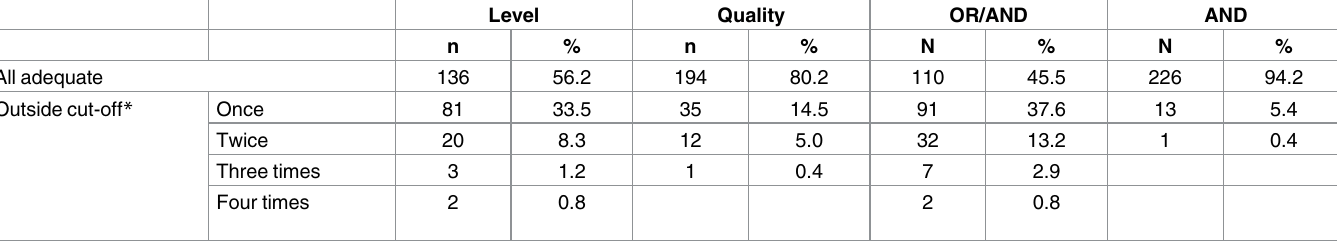
Table 3. Results of repeated assessmentsusing Structured Observation of Motor Performance in Infants.